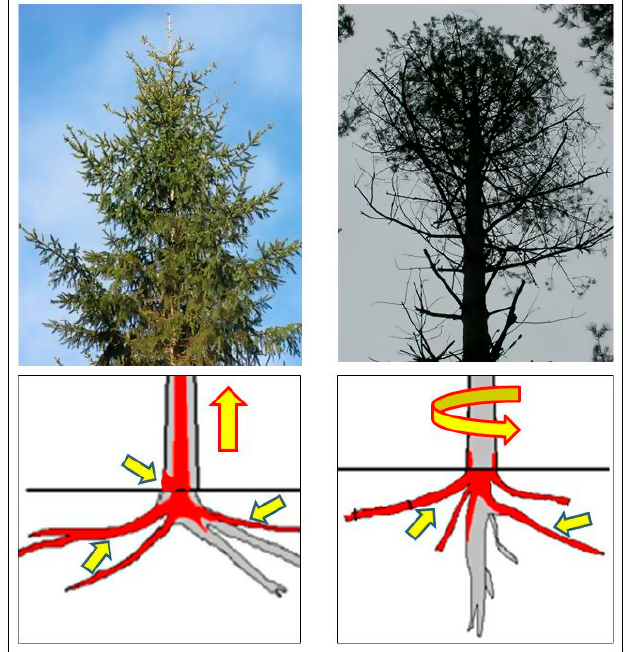
Figure 1. Differences in symptoms in the crowns of Norway spruce (left, no symptoms) and Scots pine (right, crown thinning, dying tree), with diagrams of Heterobasidion spp. mycelium spread in the affected trees (arrows).